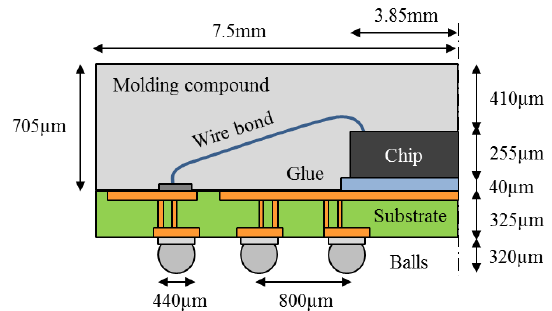
Figure 1. Semi-cross-section of the studied BGA208.